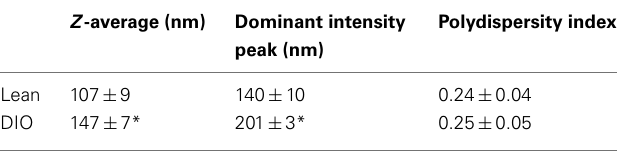
in DIO compared to lean mice.